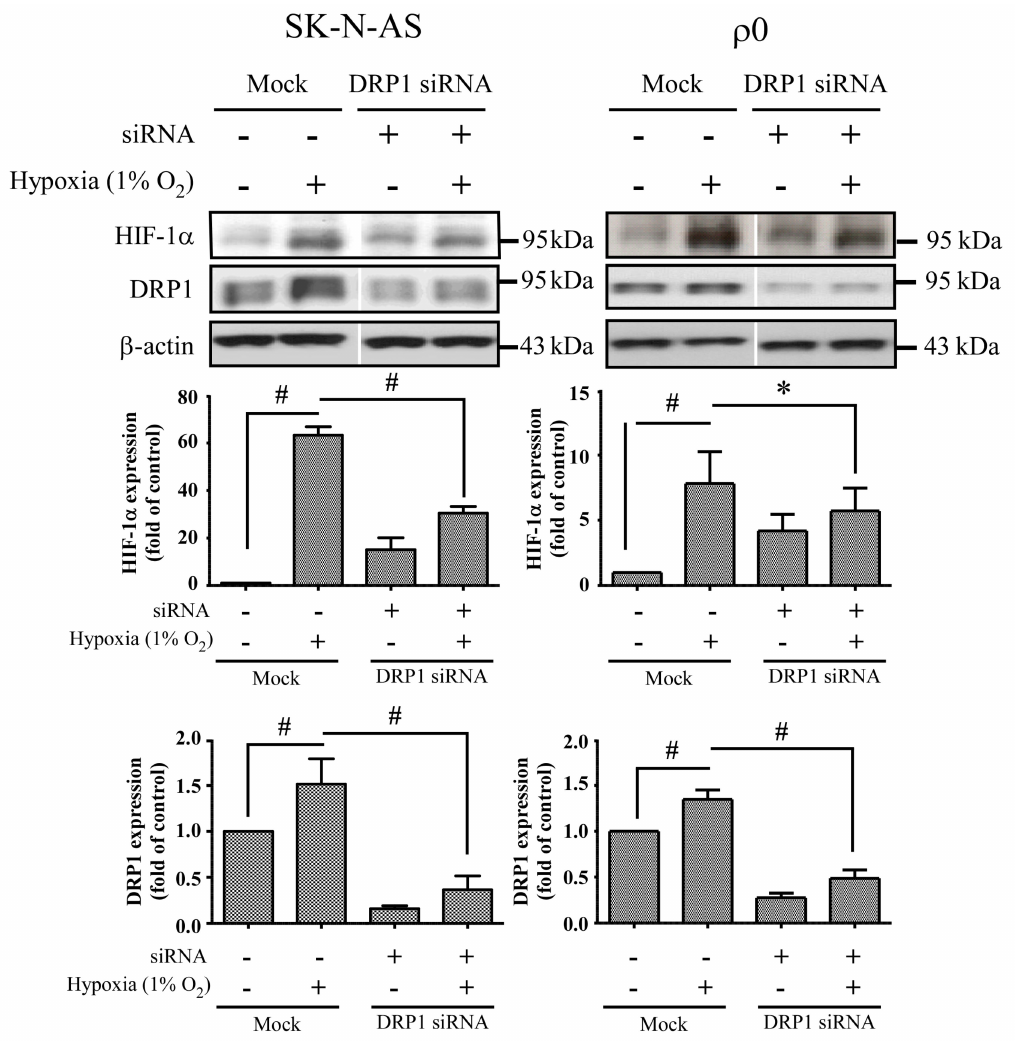
Figure 8. The effect of DRP1 siRNA. Cells were transiently transfected with siRNA targeted for DRP1 (DRP1 siRNA) or non-specific siRNA (Mock) for 24 h, and then incubated in normoxia or 1% O 2 for 4 h. The expression of HIF-1 α , DRP1 and β -actin proteins were revealed by Western blot analysis, and the quantification analyses are shown below. β -Actin was used as a loading control. The results are shown as mean ± SD of at least three experiments. * Represented p < 0.05 and # represented p < 0.005 when compared to normoxic Mock condition were determined using the one-way